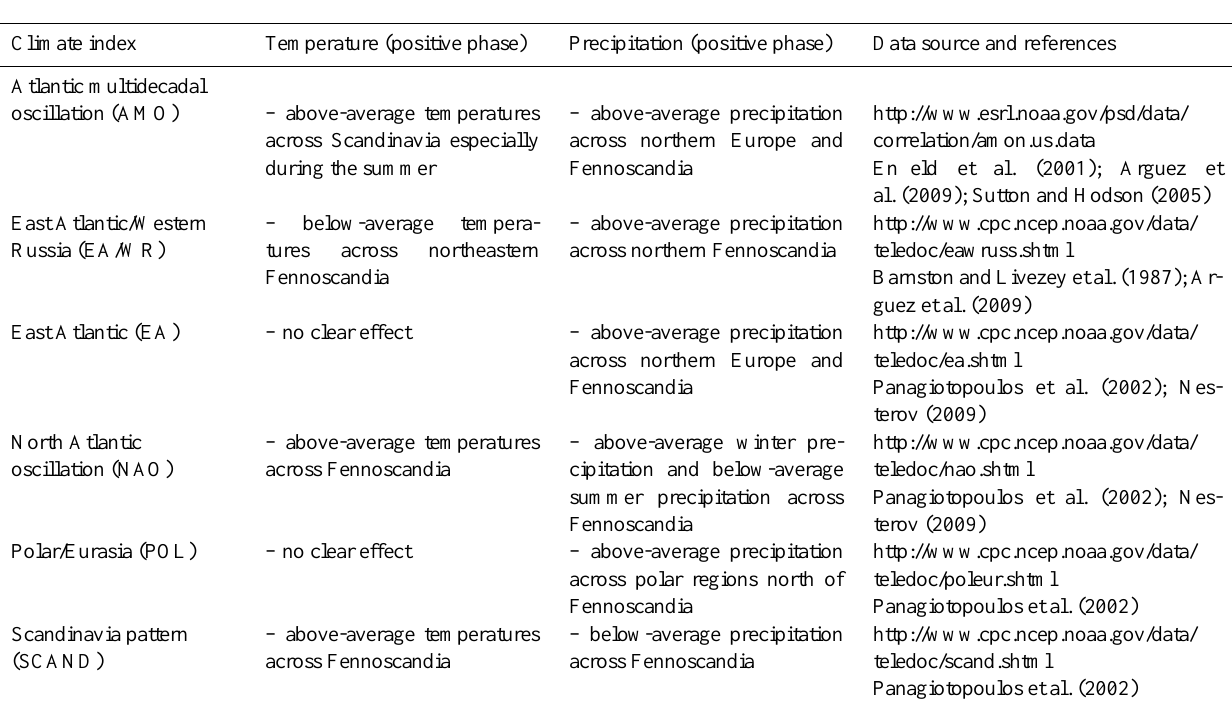
Table 1. Summary of climate pattern indices considered in this study and their relationship to temperature and precipitation anomalies in Northern Europe exemplified for the positive phase of the climate pattern indices. The monthly averaged climate index data were acquired for the period 1950–2009 from the sources specified